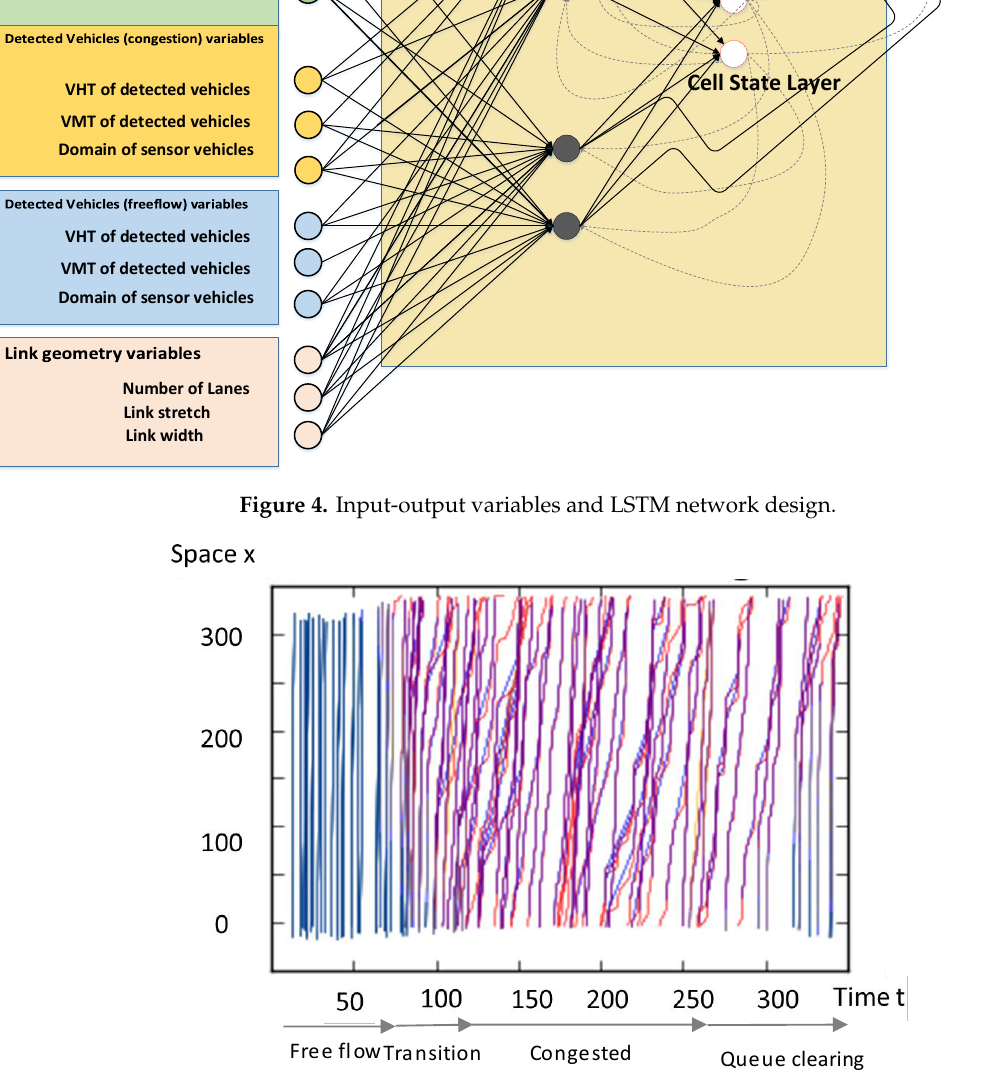
Figure 5. Vehicle trajectory variation according to the congestion level.